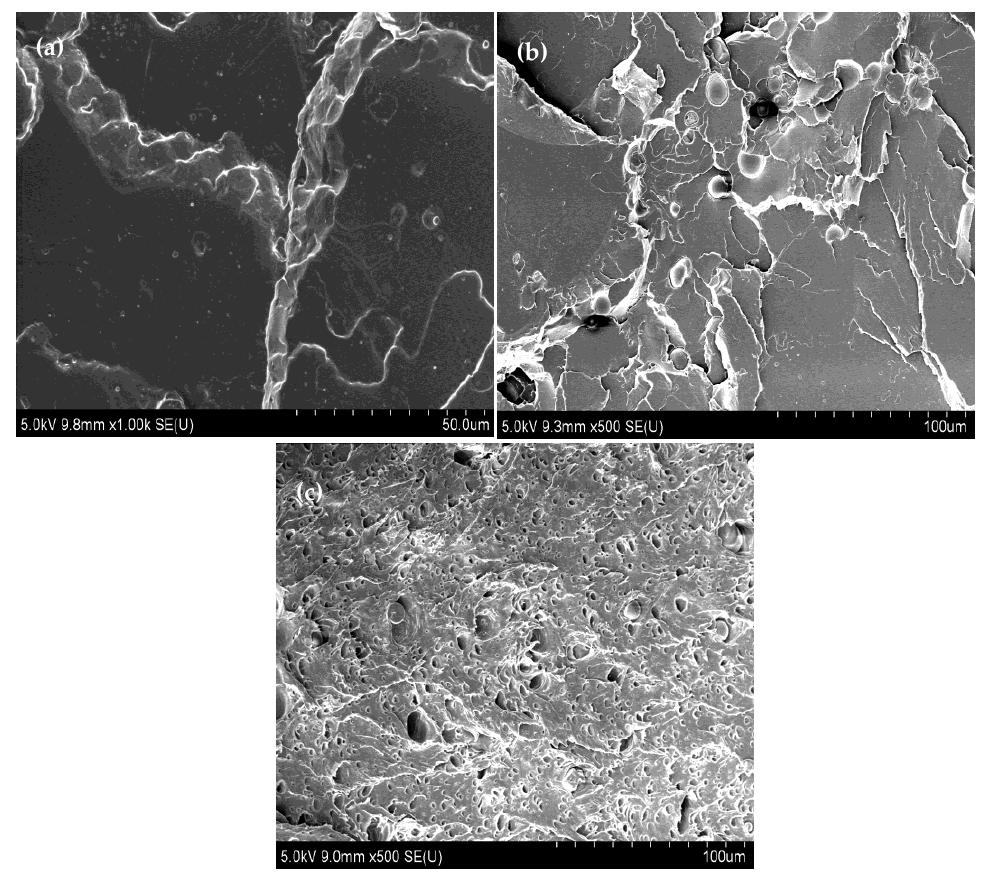
Figure 10. Surface morphology of ( a ) neat PLA, ( b ) PSt and ( c ) PSE 10. Polymers 2018 , 10 , x FOR PEER REVIEW